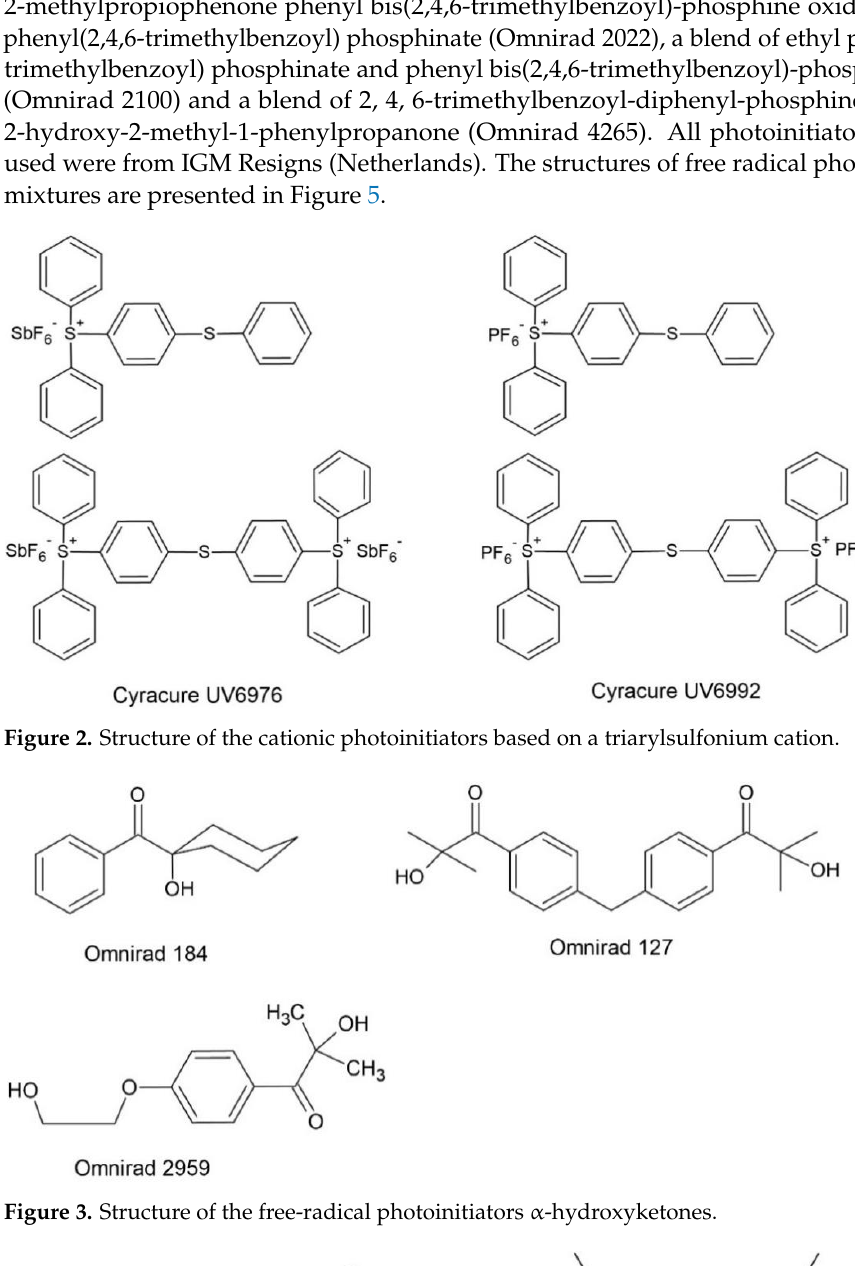
Figure 3. Structure of the free-radical photoinitiators α-hydroxyketones. Figure 5. Structure of the free-radical photoinitiators–mixtures. It has long been known that the effectiveness of a photoinitiator depends on matching the absorption spectrum with the emission spectrum of the light source. It is important that the maximum of the absorption peak is in the range of the lapa emission. Table 1 shows the maximum absorption peaks of the tested photoinitiators. Table 1. The maximum absorption peaks of the photoinitiators used.